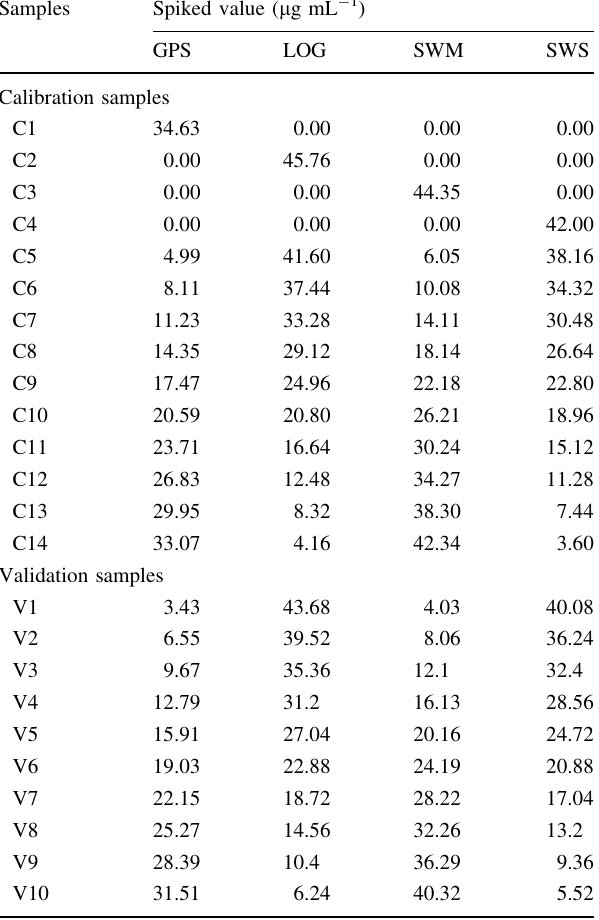
Table 1 Concentration of each analyte in calibration and validation samples